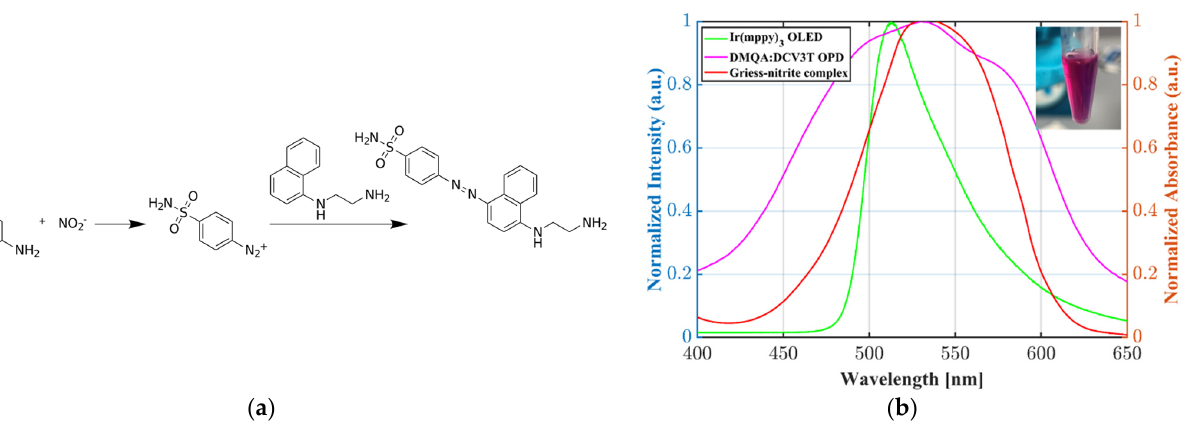
Figure 4. Nitrite measurement detection setup. The system is housing an OLED–OPD matrix, contacted with elastomeric ZEBRA ® connectors and a printed circuit board (PCB) with mirrored electrodes design ( Step I ). The organic platform and the PCB are pressed to each other with a milled mount. The fluid chamber is sealed with a rubber seal, pressed on top of the organic OLED–OPD chip ( Step II ). Finally, the setup was used with a drilled cap for adding and removing liquids with a pipette ( Step III ).